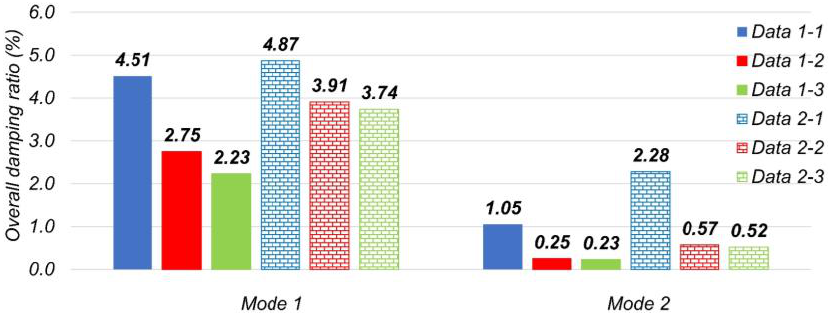
Figure 14. Overall damping ratio of the testbed structure for mode 1 and mode 2 using different data sets.